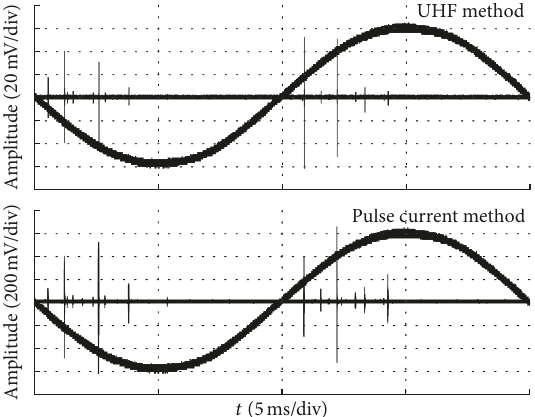
Figure 19: Partial discharge signals in a power-frequency